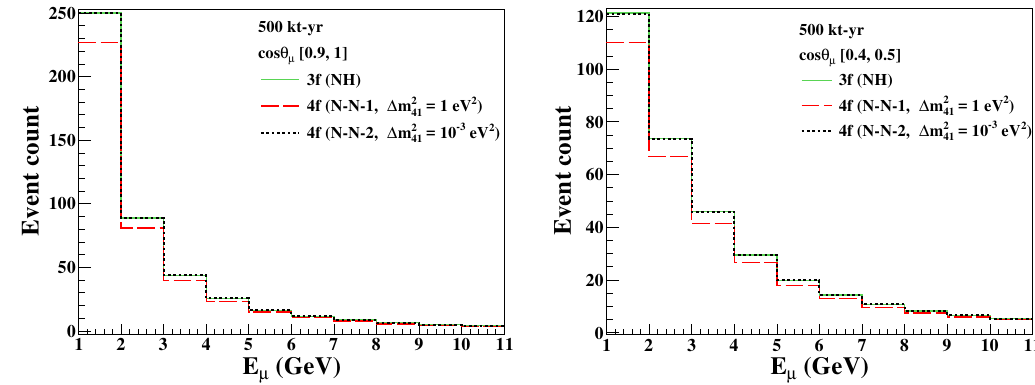
Figure 3 . (cid:22) (cid:0) event distributions for cos (cid:18) (cid:22) 2 [0 : 9 ; 1 : 0] (left panel) and cos (cid:18) (cid:22) 2 [0 : 4 ; 0 : 5] (right panel) in the three-(cid:13)avor case, and in scenarios with sterile neutrinos of two candidate (cid:1) m 2 corresponding to the N-N-1 and N-N-2 con(cid:12)gurations. We take j U e 4 j 2 = 0 : 025, j U (cid:22) 4 j 2 = 0 : 05, and j U (cid:28) 4 j 2 = 0. The information on hadron energy is not used. Note that the event distributions in the three-(cid:13)avour scenario, and in the small-(cid:1) m 2 scenario are very close, and their di(cid:11)erence cannot be discerned in the (cid:12)gure.